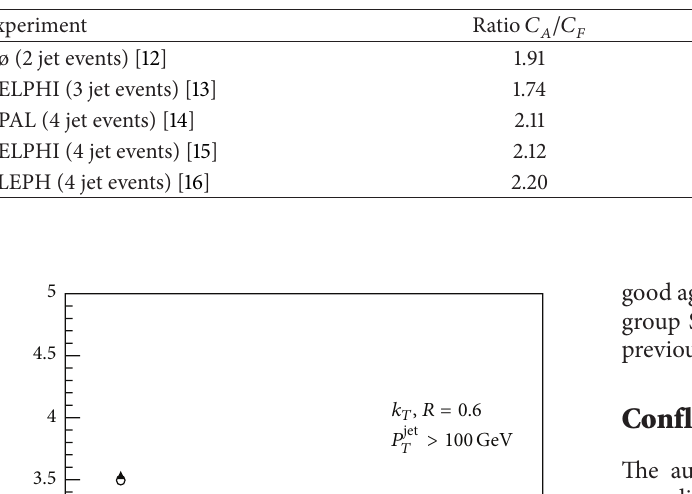
Table 7: Color factor ratio for different experiments.